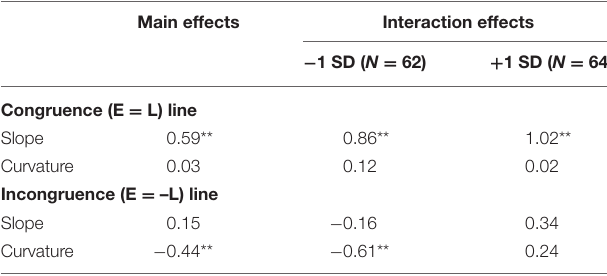
TABLE 4 | The results of slopes and curvatures along the congruence and incongruence